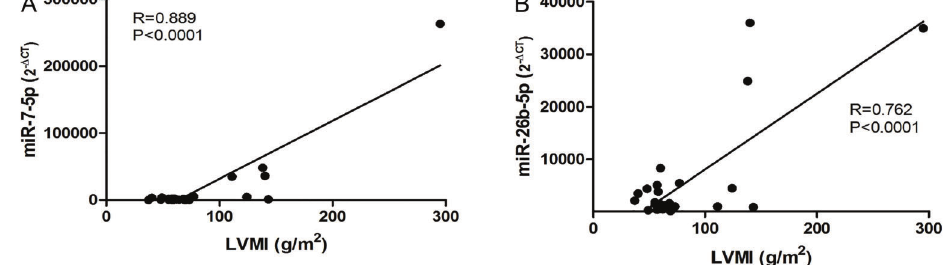
Figure 4. Left ventricle mass index (LVMI) and circulating level of miR-7-5p and MiR-26b-5p show strong correlation. A , Correlation between LVMI and MiR-7-5p. B , Correlation between LVMI and